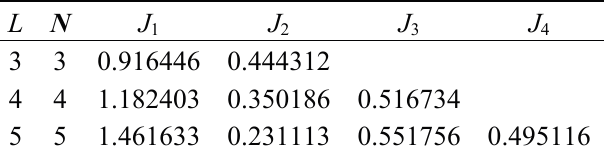
Table 4. LMShc algorithm coefficients.